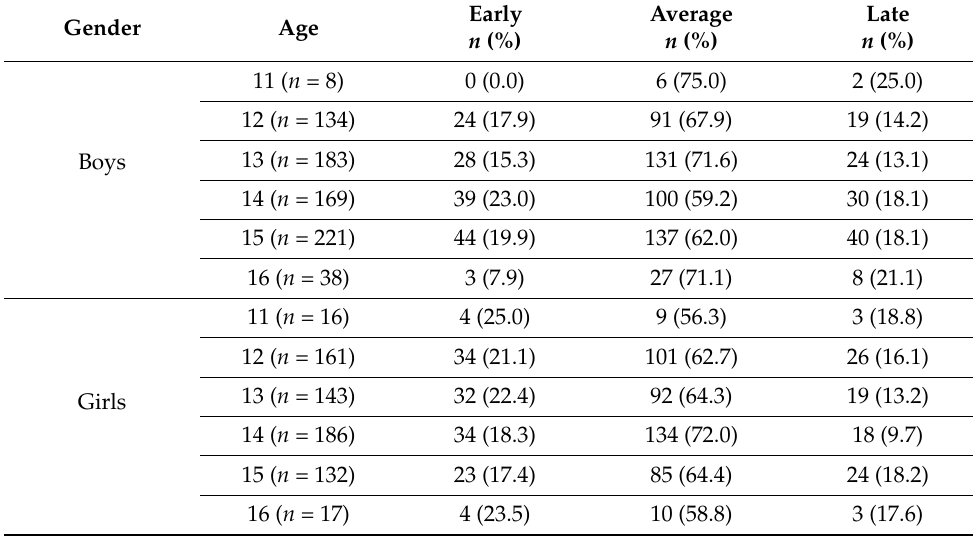
Table 1. PDS categories in groups of genders and